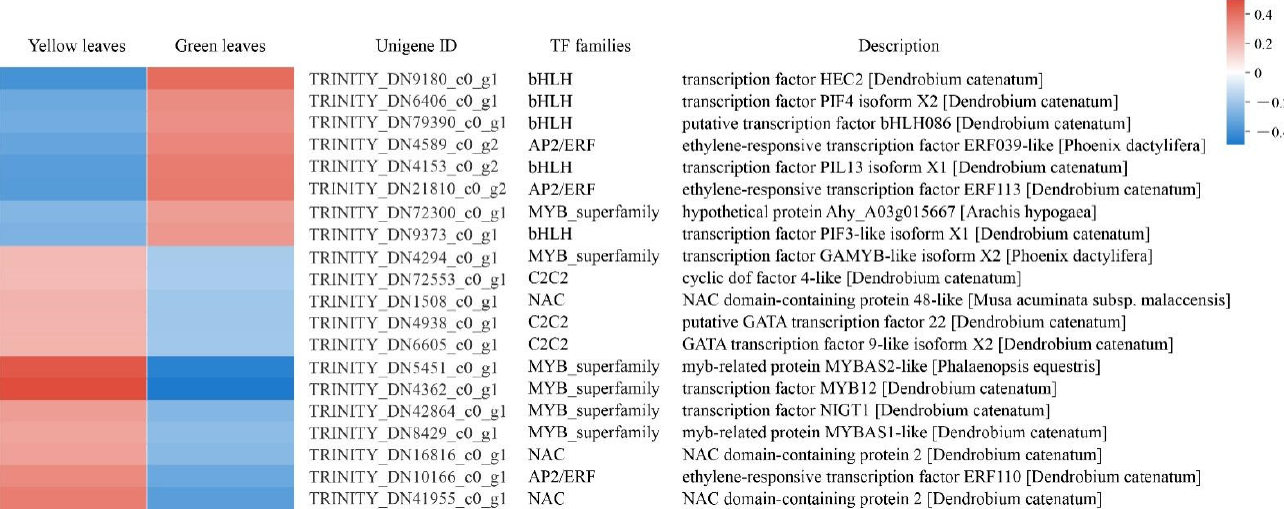
Figure 8. DEGs analysis of transcription factors (TFs) in normal green leaves and mutant leaves. Expression profiles and RNA-seq description of 20 DEGs which exhibited highly significant down or upregulation between yellow and green leaves.